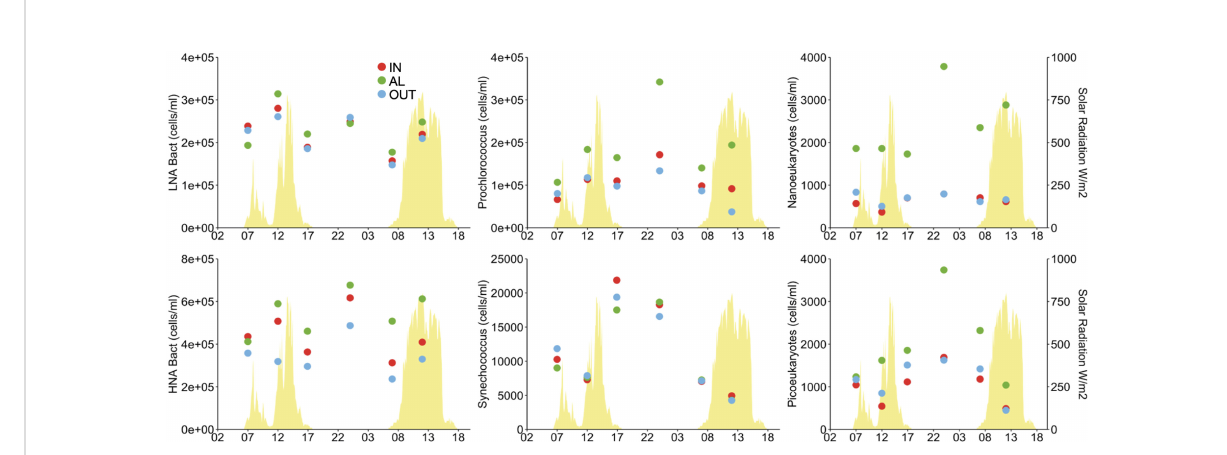
FIGURE 6 Microorganism abundances around an Acropora pulchra colony over a diel cycle as determined by fl ow cytometry. Details of where samples were collected are given in Figure 5. HNA, high nucleic acid containing heterotrophic prokaryotes; LNA, low nucleic acid containing heterotrophic